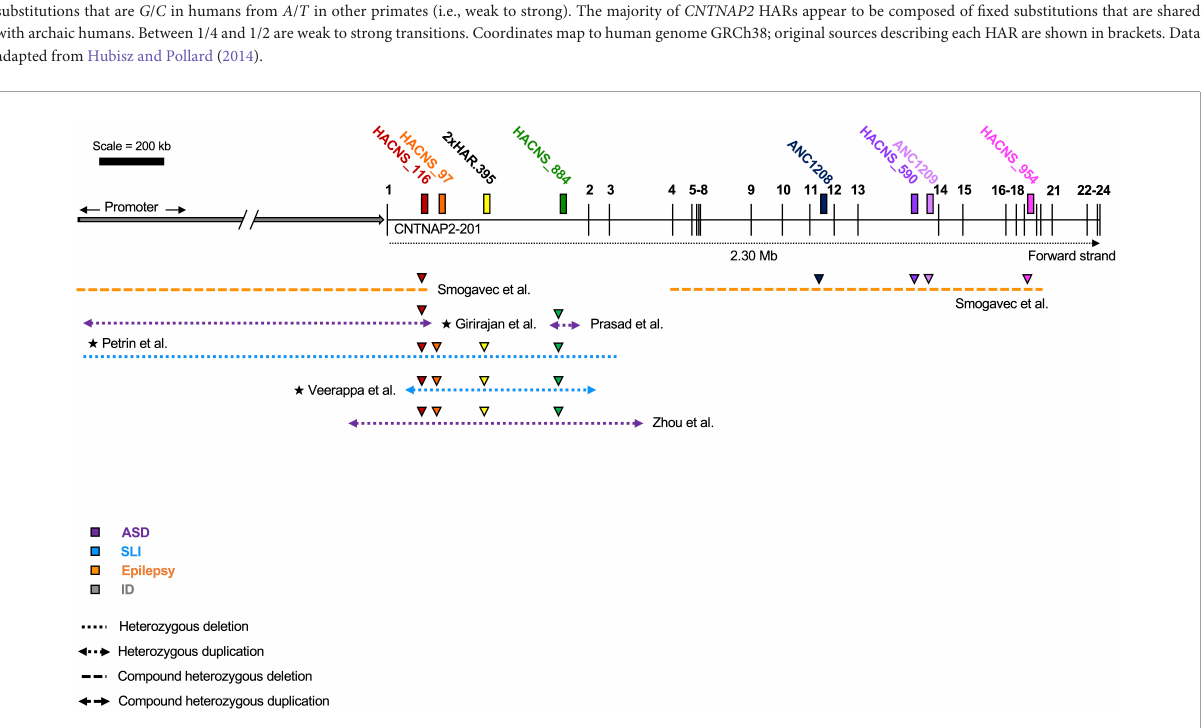
FIGURE5 Overlap of human accelerated regions (HARs) and contactin-associated protein-like 2 ( CNTNAP2 ) mutations. Disease-associated mutations that overlap one or more human accelerated region. Colored triangles indicate overlap: the color represents the specific HAR involved. Mutations in patients with multiple affected genes are marked by a star ( (cid:70) ). HACNS_116 in intron 1 intersects the most mutations (five), while ANC1208, HACNS_590, ANC1209, and HACNS_954 all intersect the fewest (one mutation). ASD (autism spectrum disorder); SLI (specific language impairment); ID (intellectual disability). Diagram not perfectly to